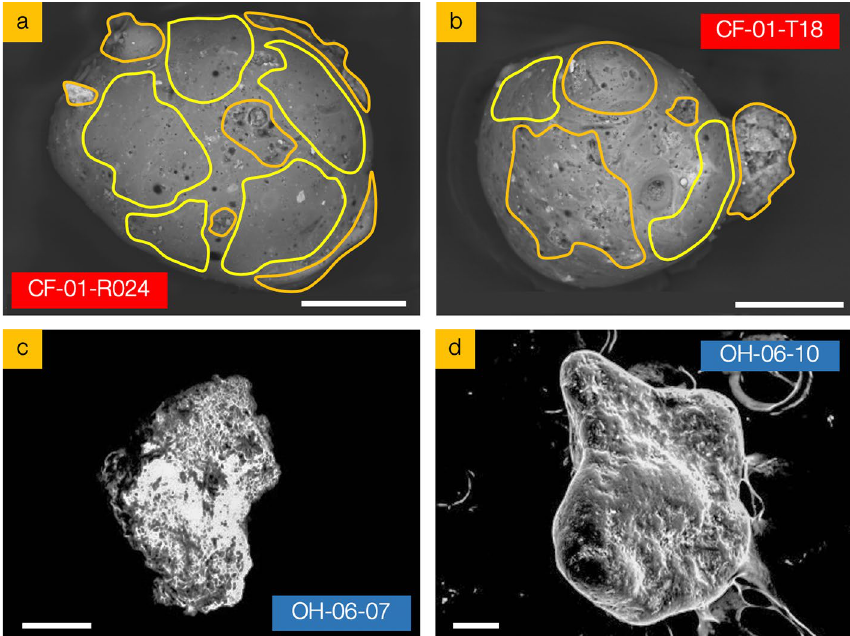
Figure 2. Electron microscope images of representative FDNPP release particulate; ( a , b ) reactor Unit 1 (CF-01-R024 and CF-01-T18) and ( c , d ) reactor Unit 3 (OH-06-07 and OH-06-10). Scale bars = 100 µm.